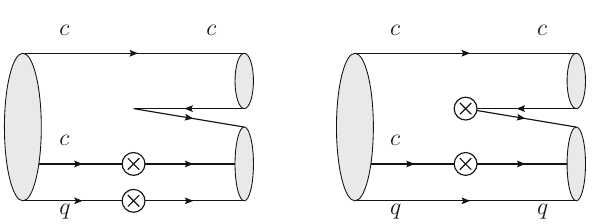
Fig. 5 The Feynman diagrams for (cid:2) cc and (cid:5) cc decays into a light baryon and a charmed meson